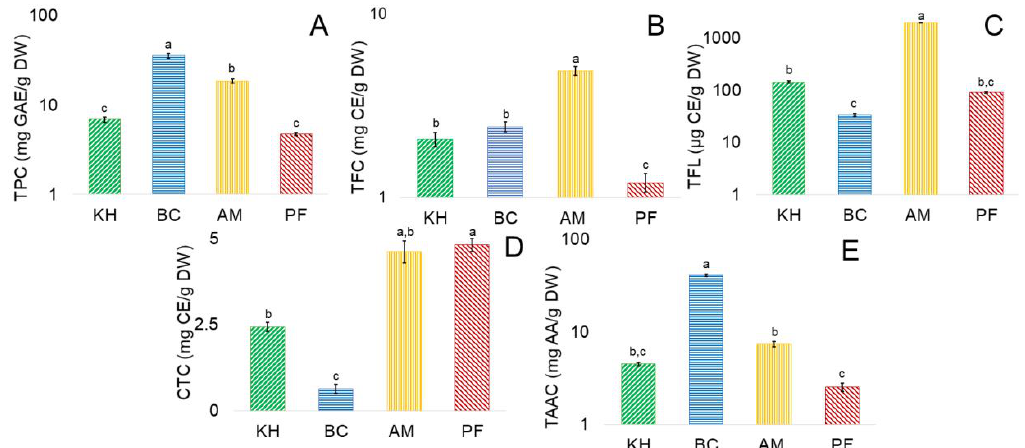
Figure 5. The content of bioactive compounds in investigated fruits. ( A ) Total phenolic content (TPC, mg GAE/g DW); ( B ) total flavonoid content (TFC, mg CE/g DW); ( C ) total flavanols content (TFL, µg CE/g DW); ( D ) condensed tannin content (CTC, mg CE/g DW); ( E ) total ascorbic acid content (TAAC, mg AA/g DW). In figures ( A – E ) values are ± SD per gram dry weight (DW); n = 5 samples per cultivar, each subsampled and analyzed five times. Values in bars with different super- script letters are significantly different between the groups of investigated fruit samples in each independent analysis of their quality ( p < 0.05). Abbreviations: KH, Actinidia (A.) deliciosa cv. Hayward; BC, A. eriantha cv. Bidan; AM, A. arguta cv. Cheongsan; PF, Diospyros kaki Thunb. cv. Fuyu; GAE, gallic acid equivalent; CE, catechin equivalent; AA, ascorbic acid; DW, dry weight.